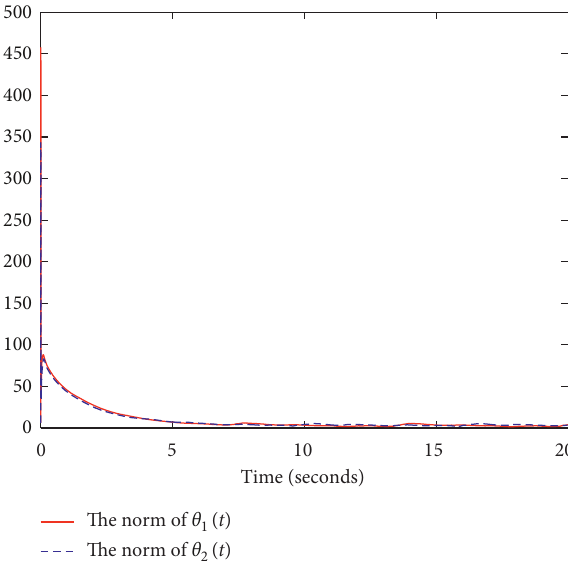
Figure 5: The norm of the fuzzy logic system parameters θ ( t ) θ 2